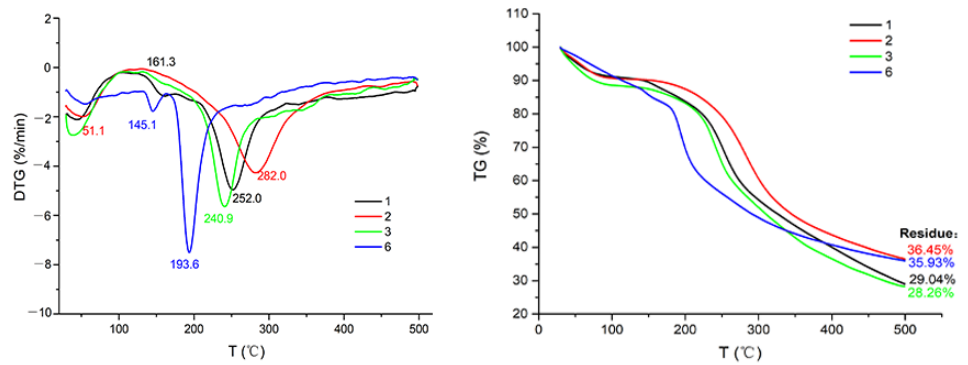
Figure 3. DTG and TG thermogram of fluoroalkenyl COS